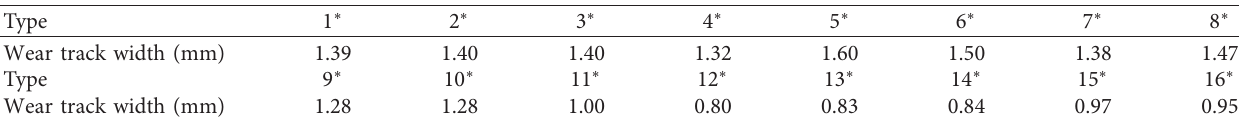
Figure 5: Photograph of EDS analysis: (a) EDS of thin film deposition part (6 ∗ ); (b) EDS of track subjected to wear test (15 ∗ ). Table 6: Average of wear track